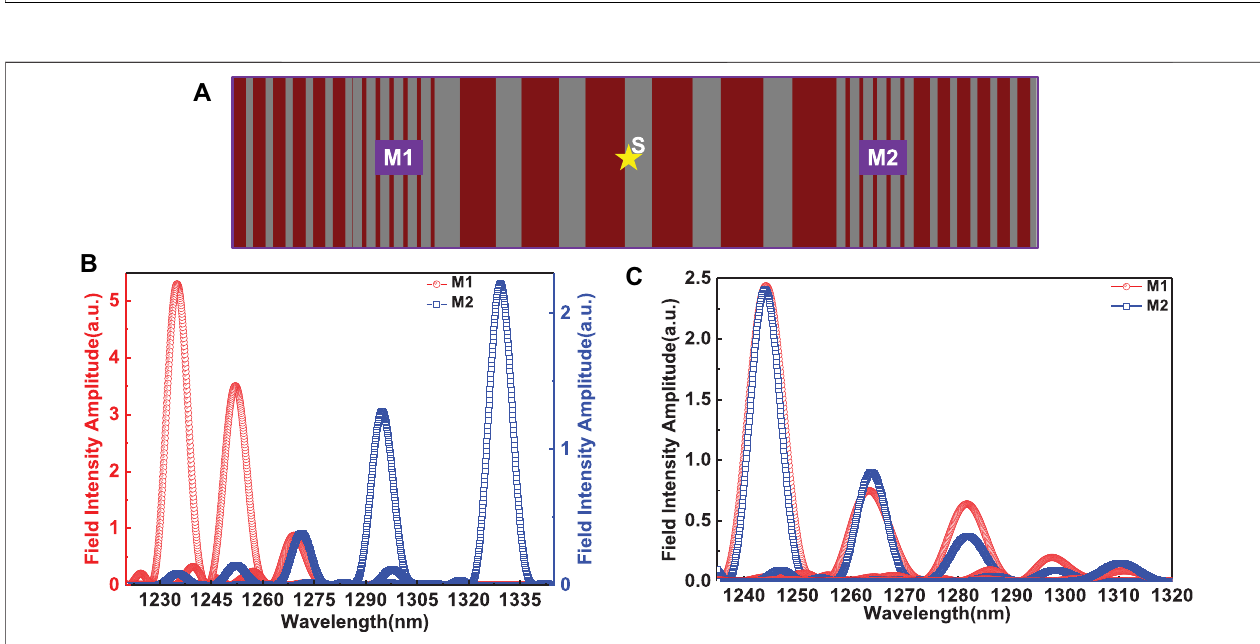
FIGURE 3 | (A) The |E| intensity distribution of the unidirectional rainbow trapping at wavelengths 1233 . 58 , 1305 . 83 , and1410 . 54 bynm when d SiO from 740nm to 785nm with an increment of 5nm and d Si from 1000nm to 1180nm with an increment of 20nm; (B) the |E| intensity distribution of the bidirectional rainbow trapping at wavelengths 1239 . 93 , 1277 . 23 , and 1308 . 64 by nm , when d SiO 1060nm.